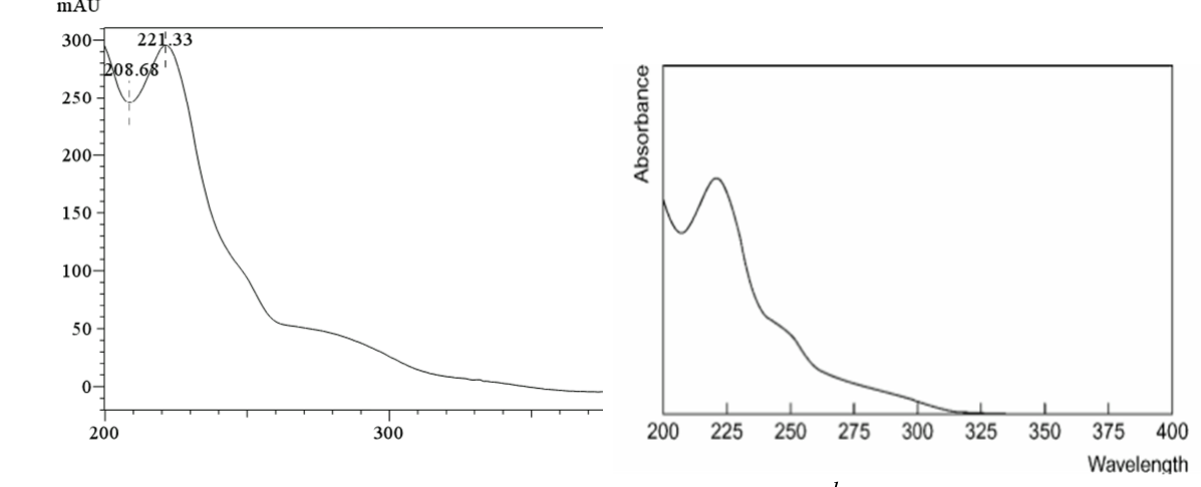
Fig. 2. Alprazolam absorbance spectrum: a – obtained by measurement with DAD detector; b – obtained from